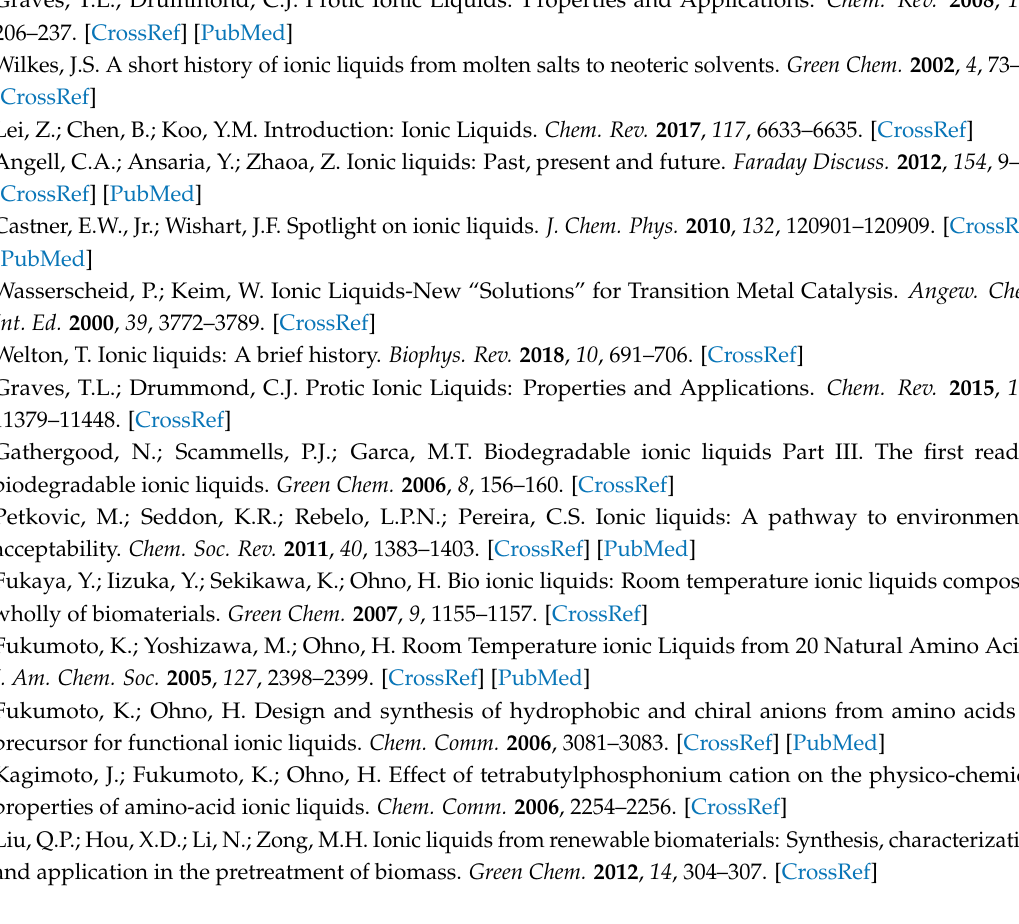
Supplementary Materials: The Supplementary Materials are available online. Figure S1. Photograph of the last prototype of EDXD diffractometer, with three detectors placed at three fixed angles; Table S1. Vibrational frequencies [cm − 1 ] calculated for the isolated and ion paired H-fumarate anion; Table S2. Vibrational frequencies [cm − 1 ] calculated for the isolated and ion paired H-maleate